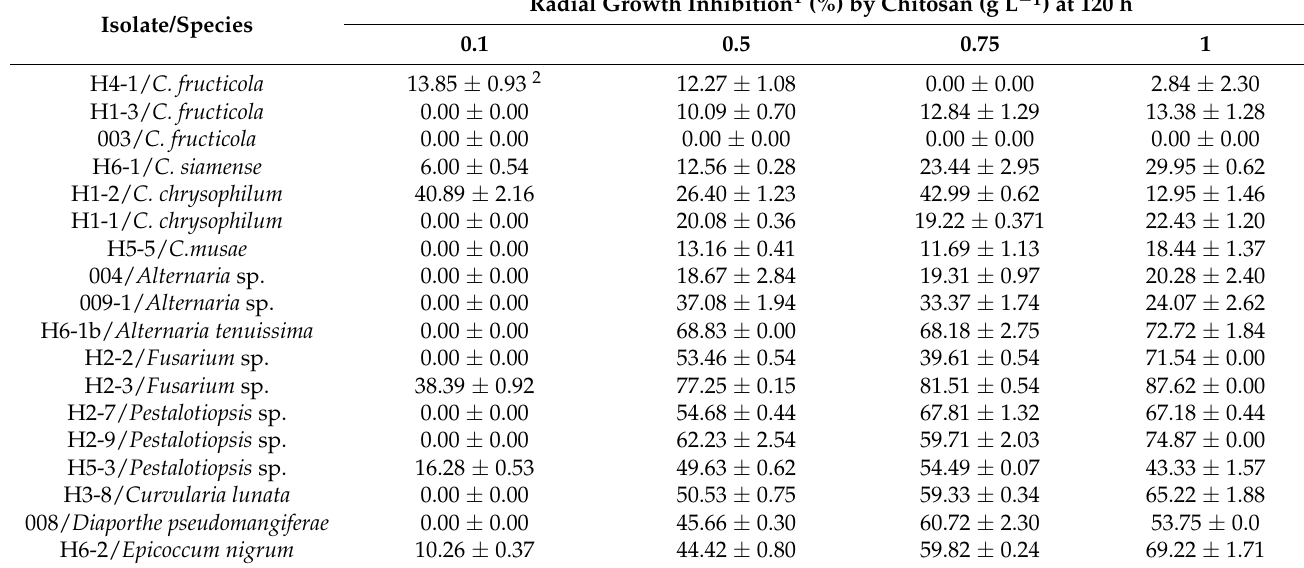
Table 2. Radial growth inhibition of Colletotrichum gloeosporioides complex isolates and other genera isolates from mango (PDA-lactic acid-chitosan) at 25 ◦